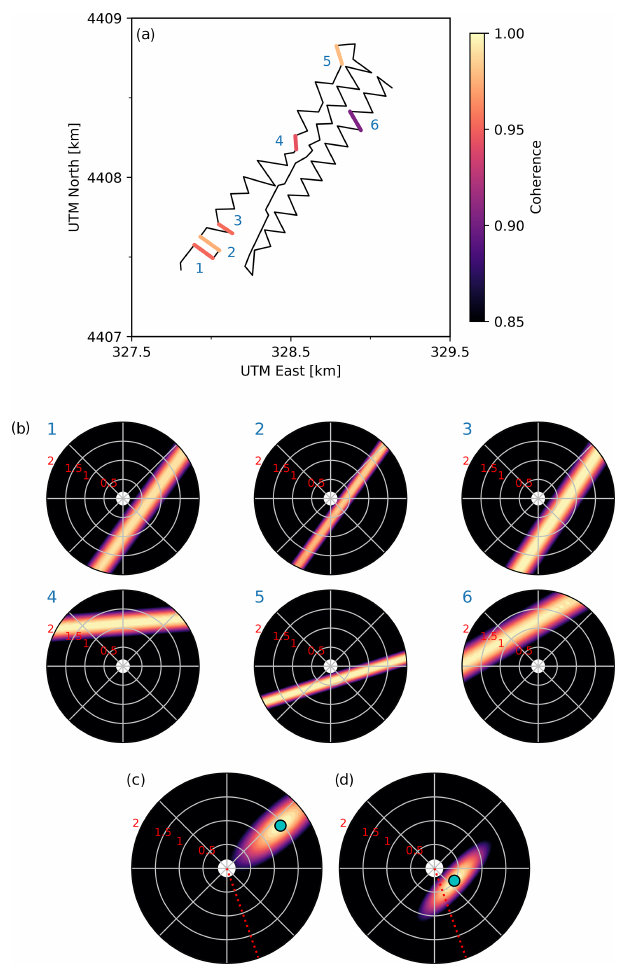
Figure 12. (a) Locations and internal coherence of six selected seg- ments along the cable, each indicated by a number; (b) beamform- ing results in the 0.5–1Hz frequency band for each of the segments. The slowness values (in skm − 1 ) of the radial grid lines are as in- dicated by the red numbers; (c) beam pseudo-power of all the seg- ments combined through Eq. (5); (d) beam pseudo-power of seg- ments 1, 2, 3, and 5 combined through Eq. (5). In (c) and (d) , the coordinate of the maximum beam power is indicated by a cyan